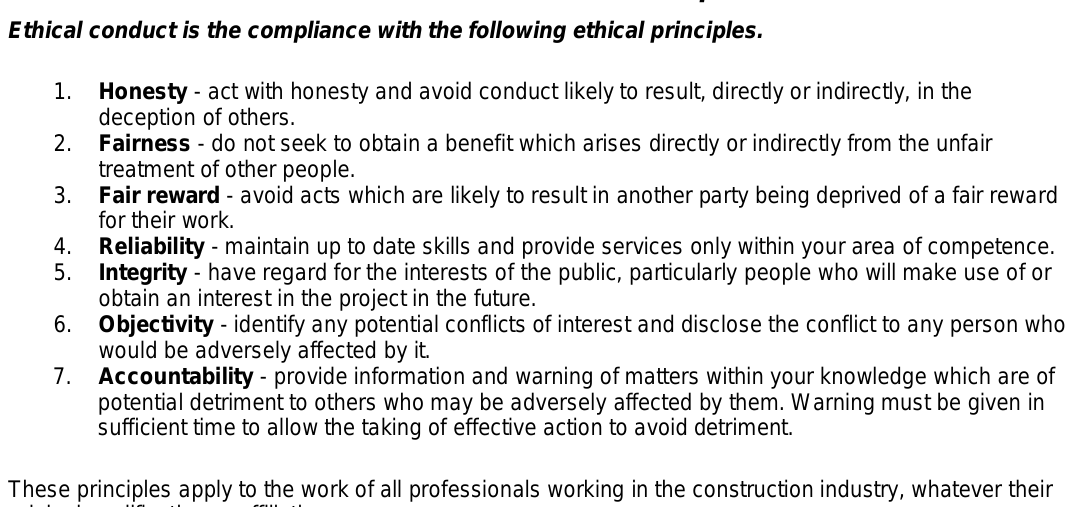
Figure 1 The Statement of Ethical Principles (reproduced with permission from the UK SoCL 5 March